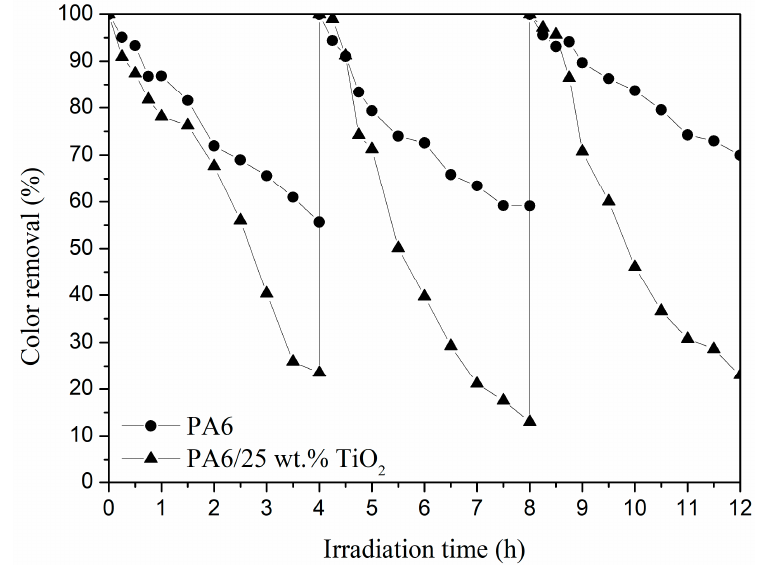
Figure 6. Photocatalytic degradation of Remazol Black B at 597 nm during the consecutive photocatalytic cycles for the PA6 and PA6/25 wt.% TiO 2 nanoparticles electrospun nanofibre membranes.